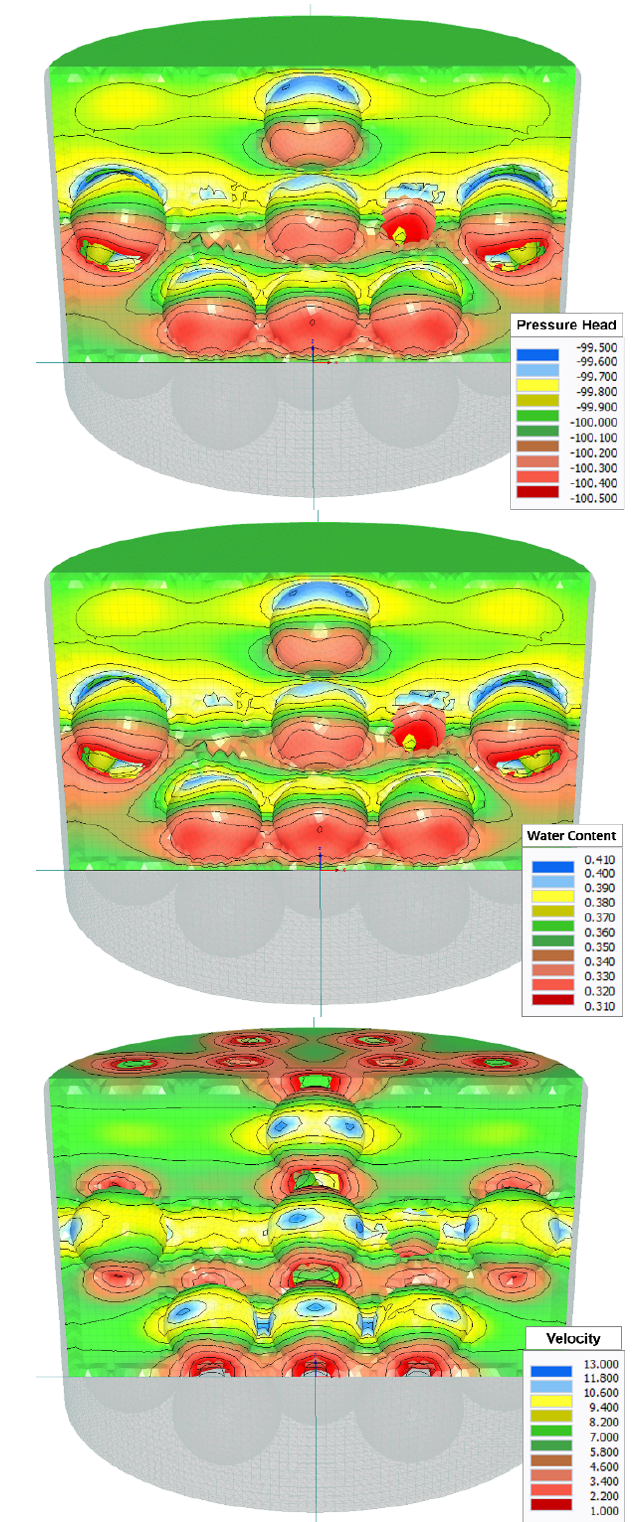
Figure 2. Visualization of the pressure head (cm), water content (cm 3 cm − 3 ), and velocity (cmd − 1 ) in a 2D profile in the center of the soil column during the forward simulation of the MSUG exper- iment.